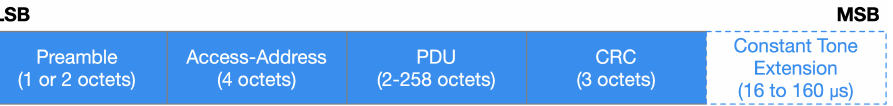
Figure 11. Structure of a Bluetooth 5.1 packet with the duration and position of the CTE. Associated apps add CTE to conventional packets, while those without a connection use an advertizing